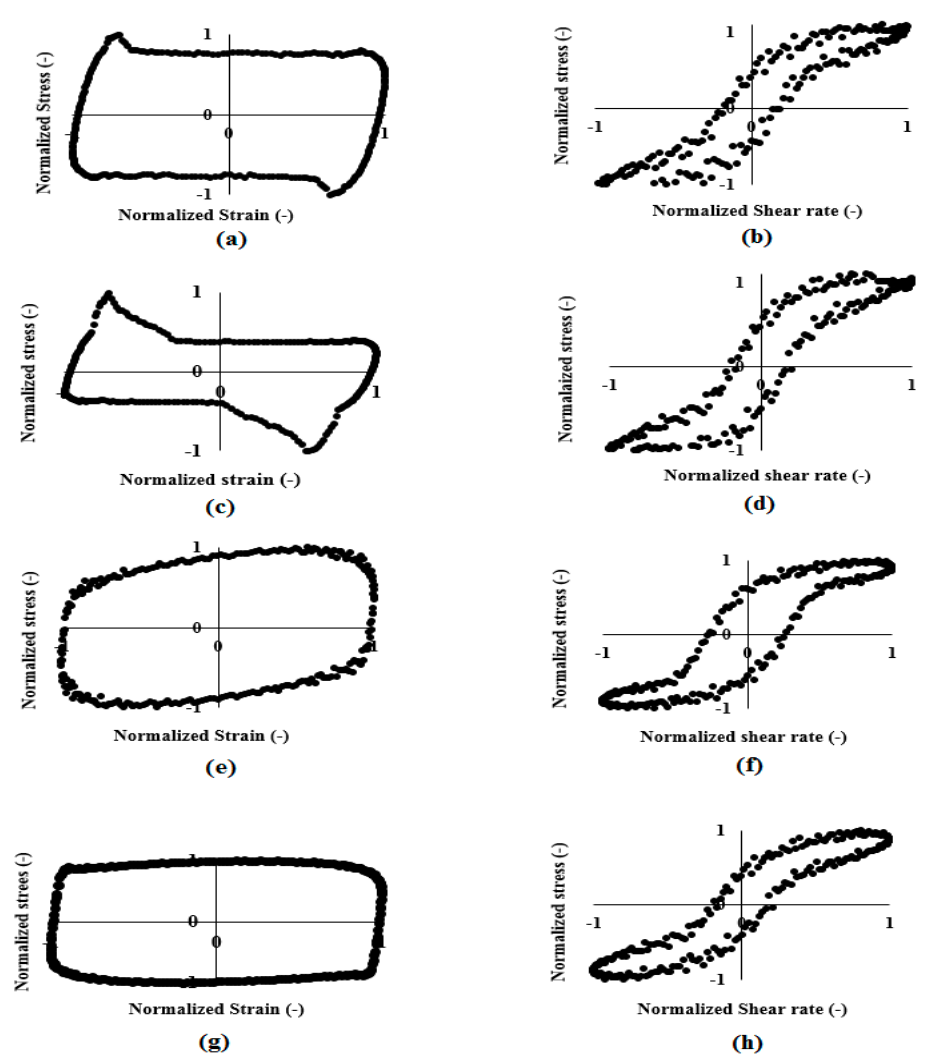
Figure 3. Elastic Lissajous plots of the SBL-extract-added Feta-cheese samples at 3rd day ( a ), 20th day ( b ), 40th day ( c ), and 60th day ( d ) and the viscous Lissajous plots at 3rd day ( e ), 20th day ( f ), 40th day ( g ), and 60th day ( h ) in n-LVE region (1 Hz and 1000% strain).